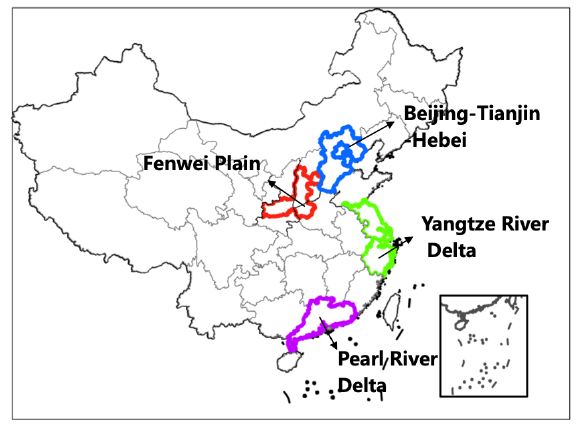
Figure 2. Four key regions are defined in this study: the Beijing– Tianjin–Hebei region, the Yangtze River Delta region, the Pearl River Delta region, and the Fenwei Plain